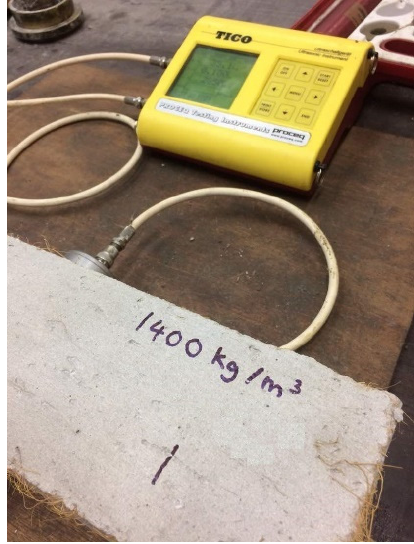
Figure 4. Ultrasonic pulse velocity test of LFC specimen.